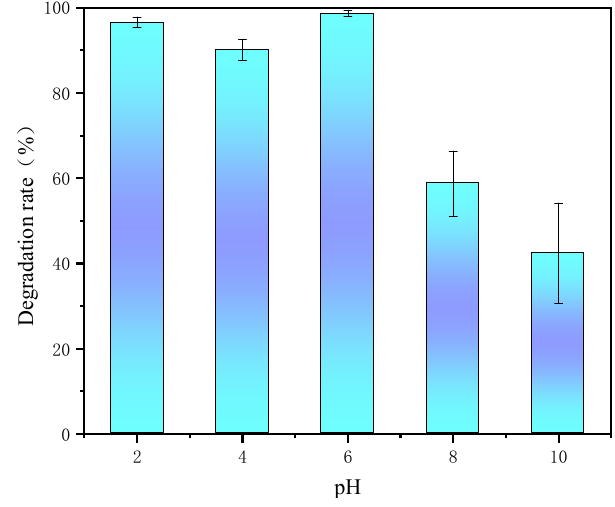
Figure 11. Effect of initial PNP concentration and linear fitting. PNP degradation curves with different initial concentrations ( a ), Dynamic fitting curve ( b ).